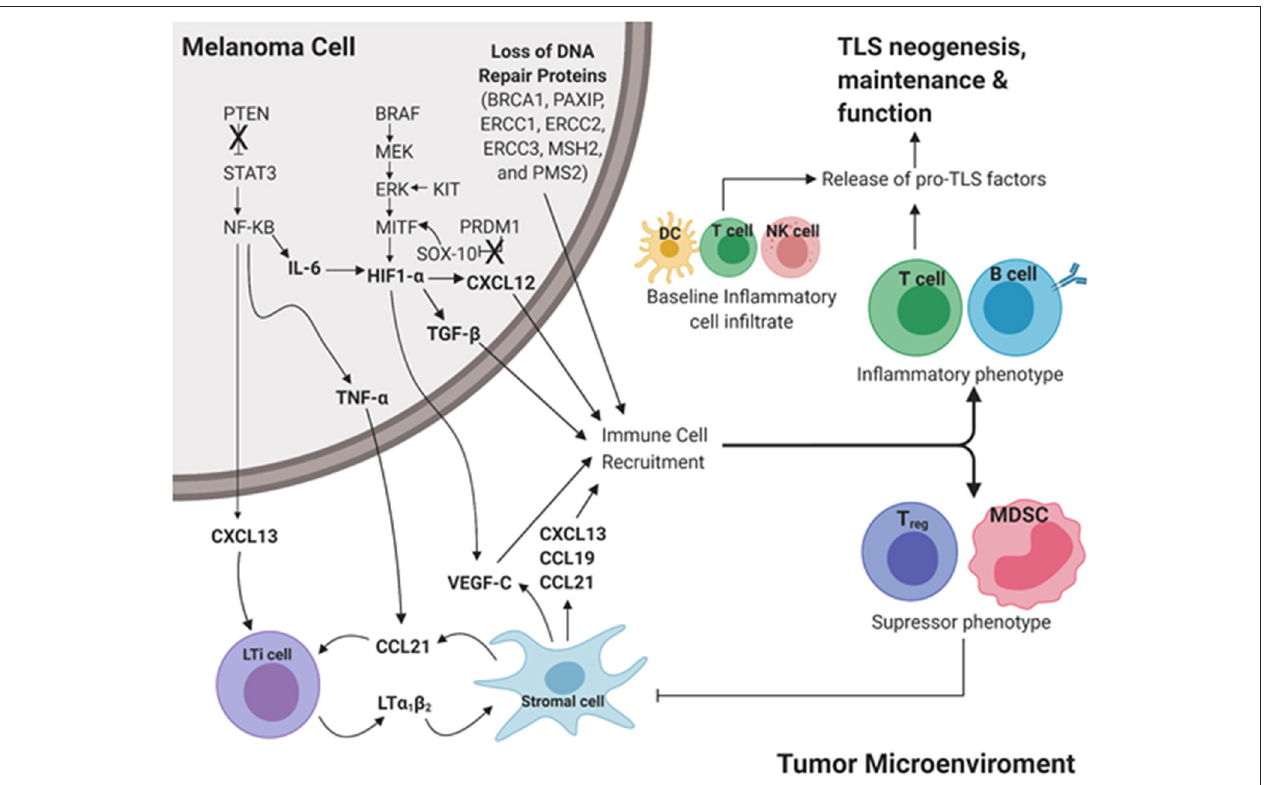
FIGURE 2 | Proposed intrinsic molecular mechanisms that contribute to TLS development downstream of common driver mutations in cutaneous melanoma. Pro-inflammatory cues initiate TLS neogenesis in the peripheral tumor microenvironment (TME). In a melanoma tumor cell, loss of tumor suppressor genes PTEN and PRDM1 results in increased expression of STAT3 and SOX-10, respectively. Gain of function in the proto-oncogenes BRAF, KIT, MITF results in upregulation of MEK, ERK, and HIF-1 α , respectively. Culmination of these mutations results in increased expression of pro-TLS cytokines (CCL21, CCL19, CXCL13, LTa1b2) and pro-inflammatory immune cell recruitment (T cell, B cell) contributing to the development, maintenance, and function of TLS in the TME (Inflammatory phenotype). The lack of proinflammatory cues in the TME contributes to the recruitment and maintenance of immunoregulation (Treg, MDSC) resulting in an immunosuppressive TME (Immunosuppressive phenotype). The ever-changing balance of pro-inflammatory vs. regulatory immune function in TLS likely dictates the anti- vs. pro-tumor influence TLS play in disease outcome. LTi cell, Lymphoid tissue inducer cell; MDSC, Myeloid derived suppressor cell; DC, Dendritic cell; NK cell, Natural killer cell. Created with